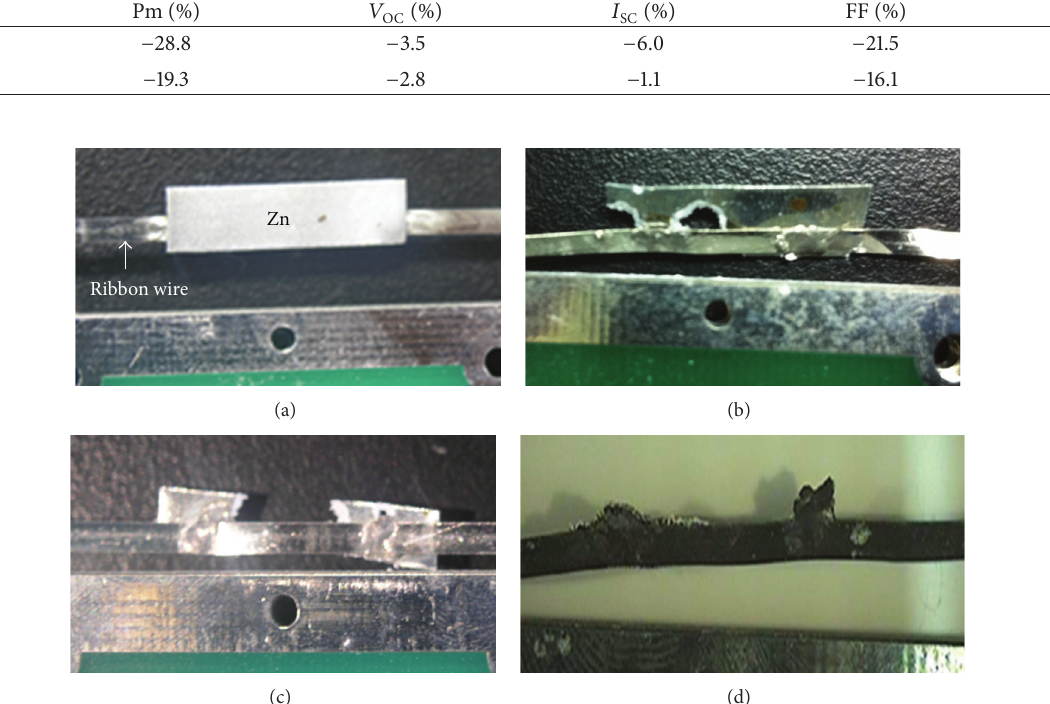
Figure 6: Corrosion of the sacrifice metal, Zn, with DH exposure: (a) initial, (b) 200 h, (c) 500 h, and (d) 1000